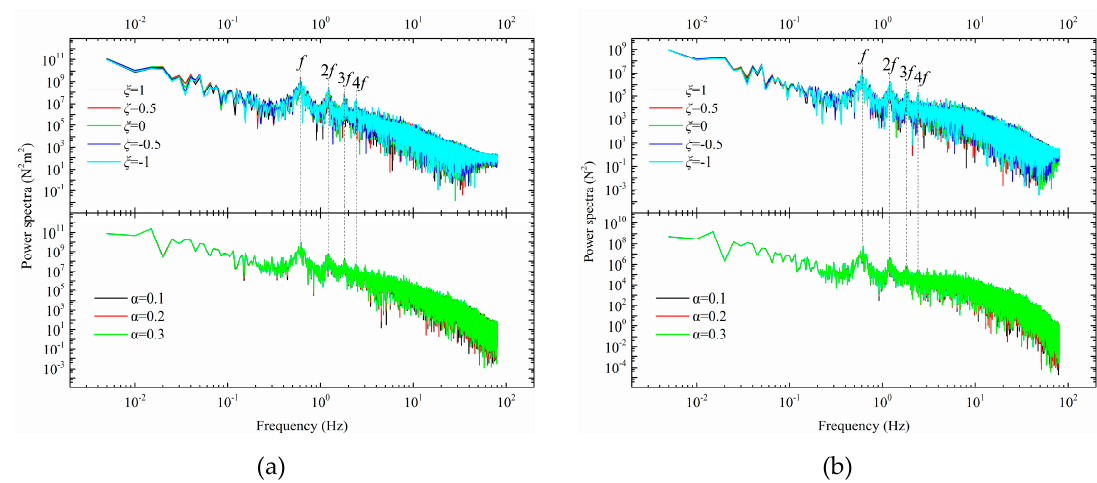
Figure 12. Power spectrum characteristic curve of rotor thrust coefficient and torque coefficient in LLJ and shear inflow condition: ( a ) torque and ( b ) thrust.